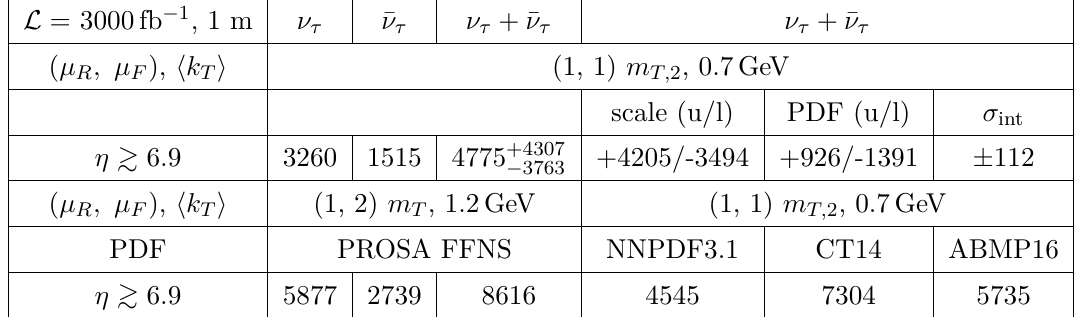
√ produced in pp collisions at s = 14 TeV for an s